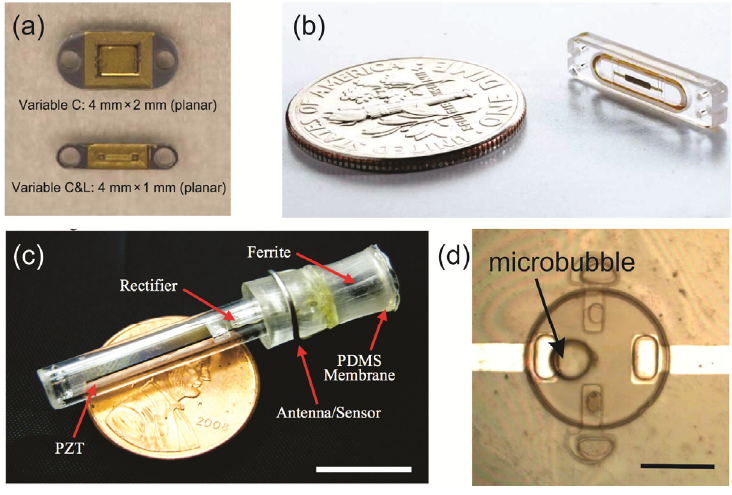
Figure 2. Examples of implantable pressure sensor systems currently in development: ( a ) A capacitive-based sensor for measurements of intraocular pressure [39]; ( b ) Capacitive-based sensor developed by CardioMEMS for measurements of blood pressure; ( c ) Inductor-based sensor with piezoelectric energy harvester for measurements of bladder pressure (scale bar 10 mm) [45]; ( d ) Micro-bubble based pressure sensor for measurements of intracranial and bladder pressure (scale bar 100 µm)